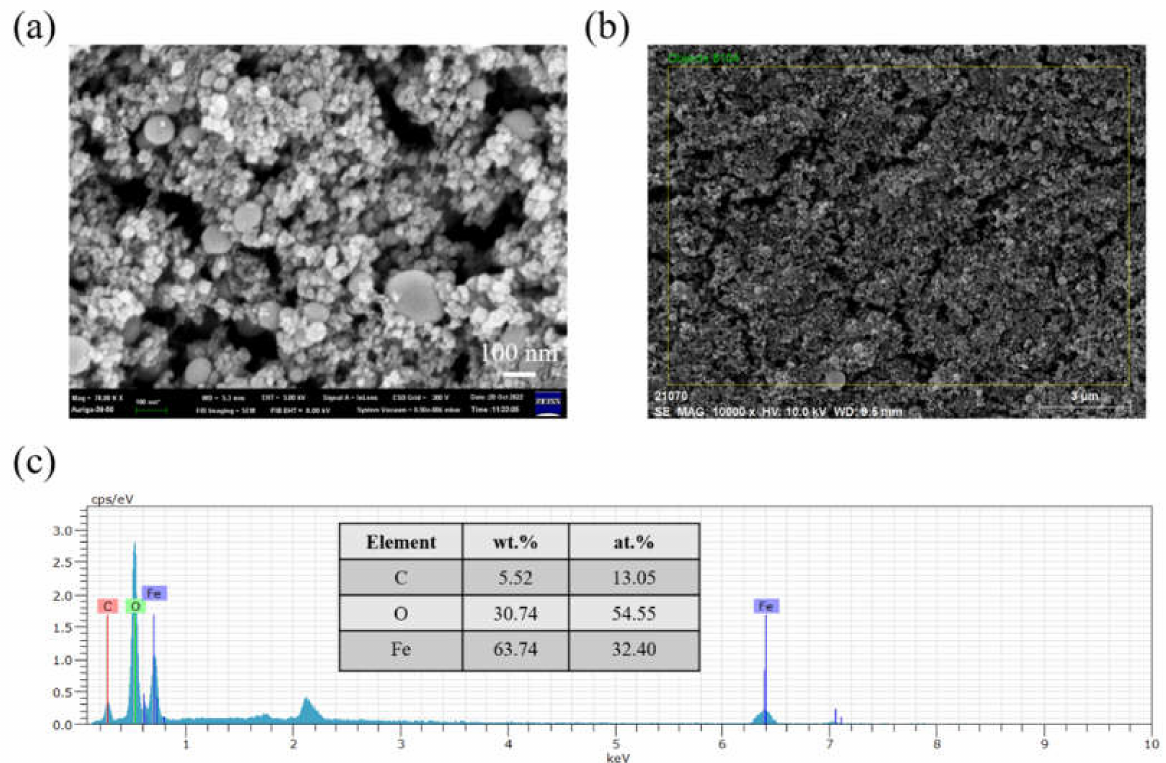
Figure 3. ( a ) SEM image; ( b ) SEM image corresponding to ( c ) EDS analysis of Fe 3 O 4